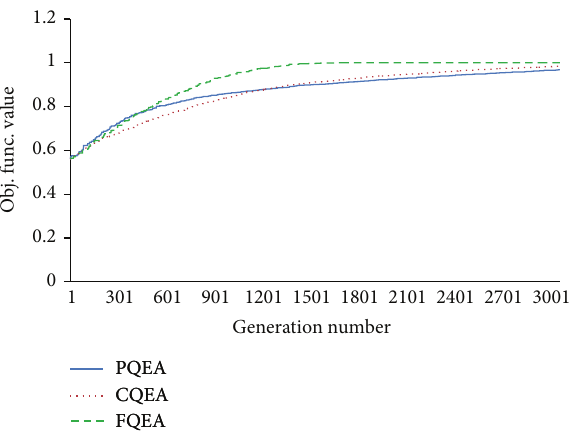
Figure 18: Convergence graph of PQEA, CQEA, and FQEA on 𝑃 - PEAKS problem of size, 𝑁 , being 1000 and number of peaks, 𝑃 , being